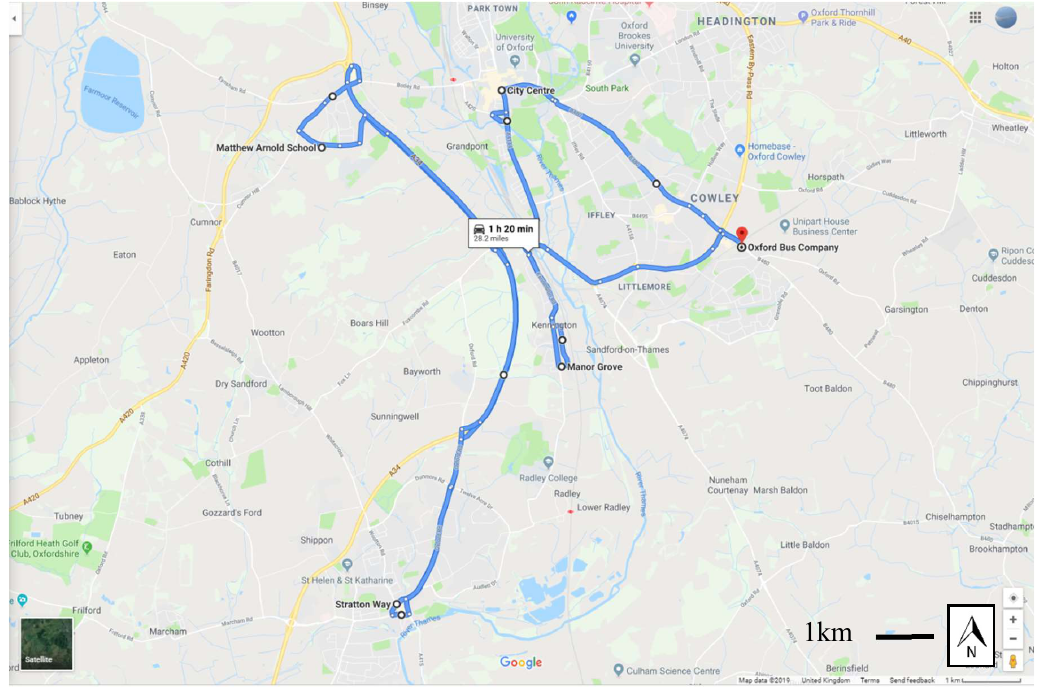
Figure 4. Routes taken by Euro V bus in the first part of the day (map data © Google).